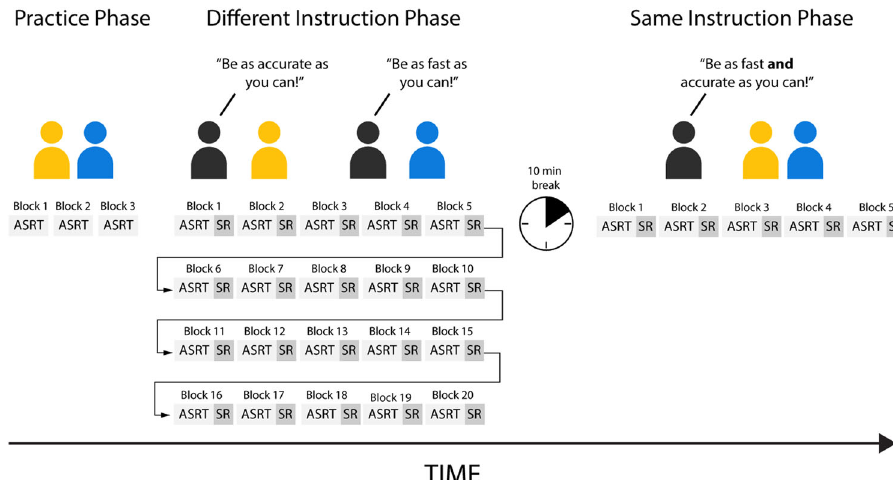
Fig. 5 Study design. Participants completed three blocks of practice to familiarize themselves with the task. After that, participants received instructions to either be accurate (Accuracy Group) or fast (Speed Group) during the next phase of the experiment (Different Instruction Phase). Moreover, they were told that speci fi c stimuli (the dogs) followed a predetermined sequence, and they should use this information to improve their performance. Participants completed 20 blocks of the ASRT task. After each block ASRT task, participants had to perform the sequence report task (SR). After the Different Instruction Phase, participants rested for 10 min. Next, during the Same Instruction Phase, the participants ’ tasks remained the same, but this time, they were instructed to be equally fast and